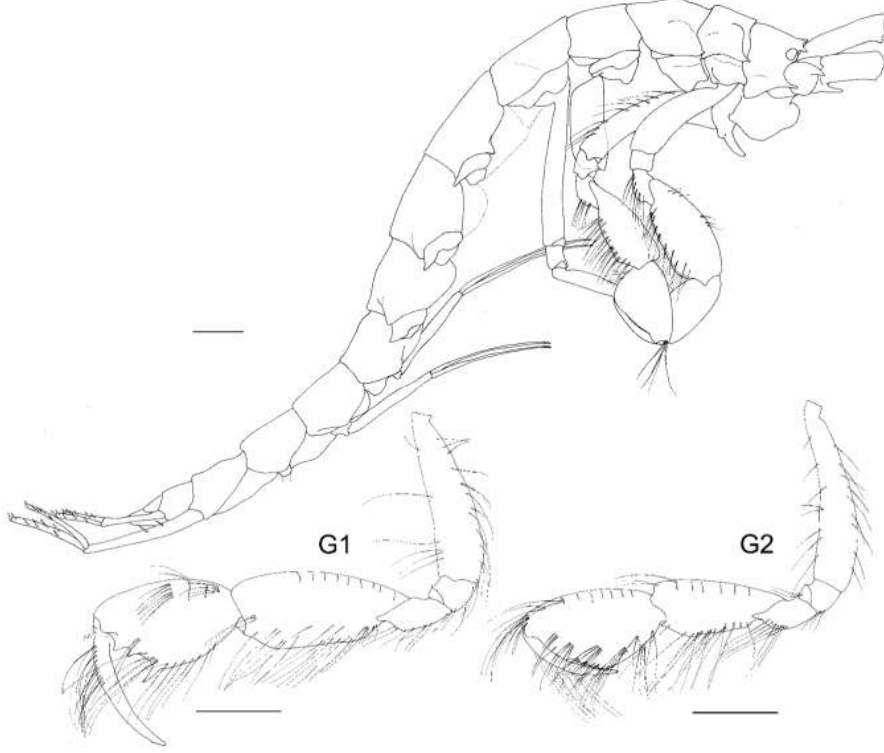
Figure 3. Neohela monstrosa (Boeck, 1861) male, 19 mm, SMF 52.259, Norwegian Sea, Norwegian Basin, North Atlantic, 1886 m ; scale habitus: 1 mm, gnathopods 1–2 scale: 0.5 mm.